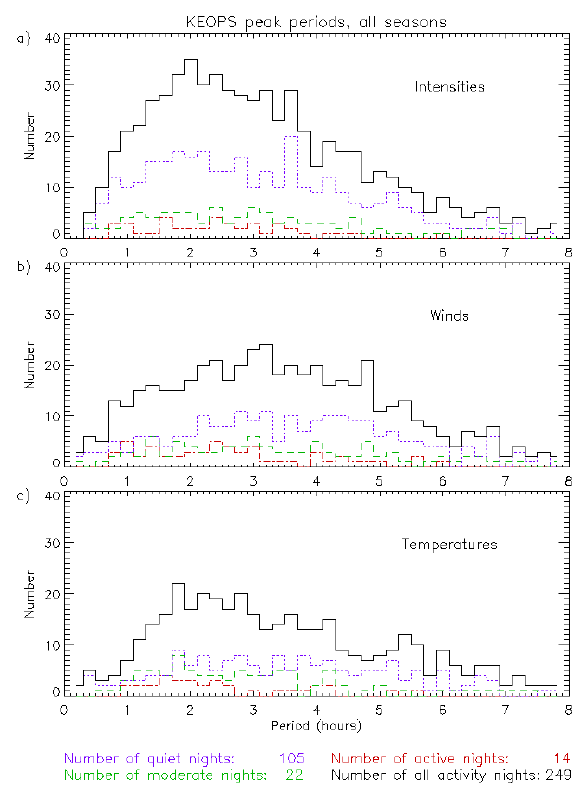
Fig. 8. Histogram of gravity wave periods for all KEOPS data (2000–2006) at all activity levels: (a) intensities, (b) winds, and (c)